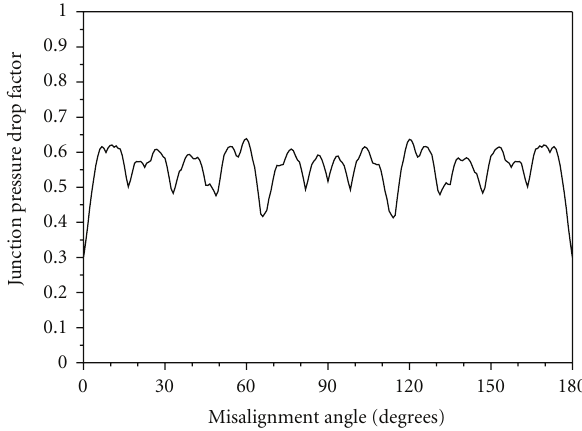
Figure 13: CARA junction pressure drop predicted by